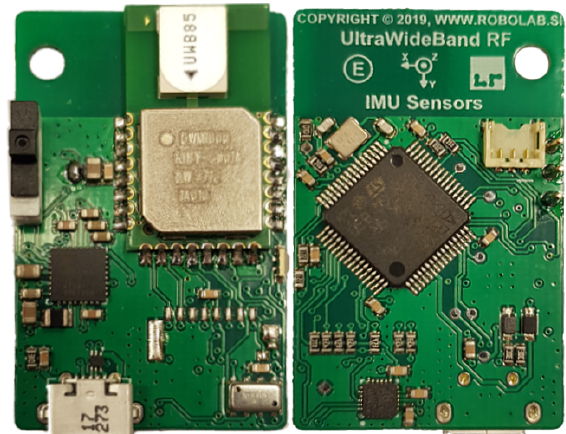
Figure 1. Top and bottom sides of the designed board with the ultra-wideband (UWB) radio